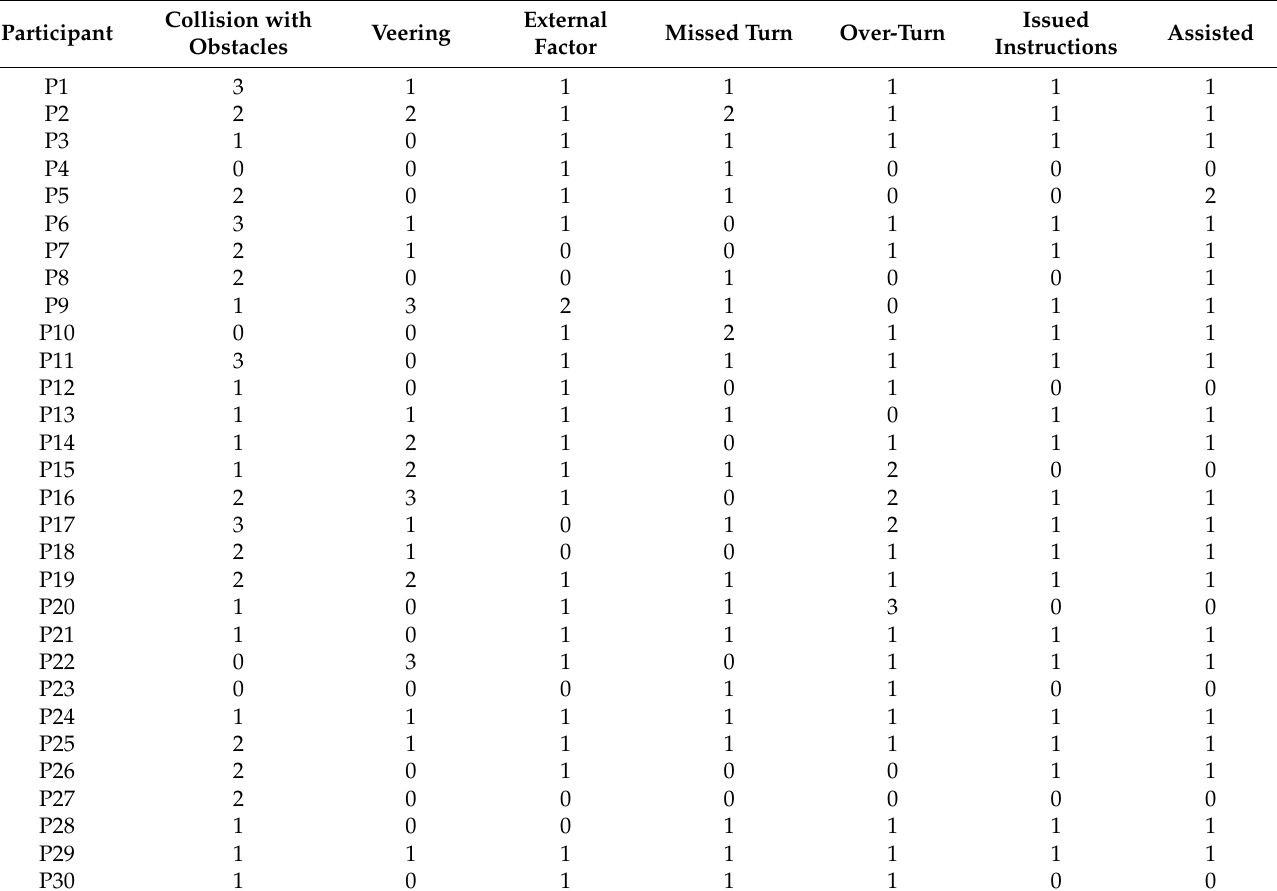
Table 3. Pedestrian Navigation